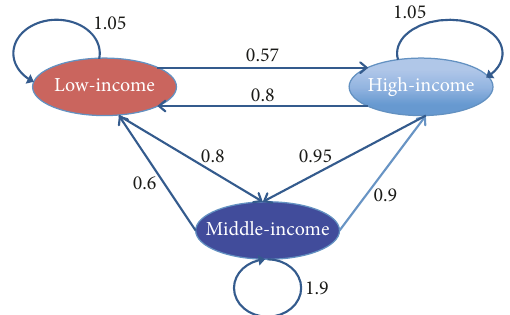
Figure 3: Parental income, the average preference of nodes with a particular value for all values of the attribute. Unlike others, parental income data was collected only once by the first